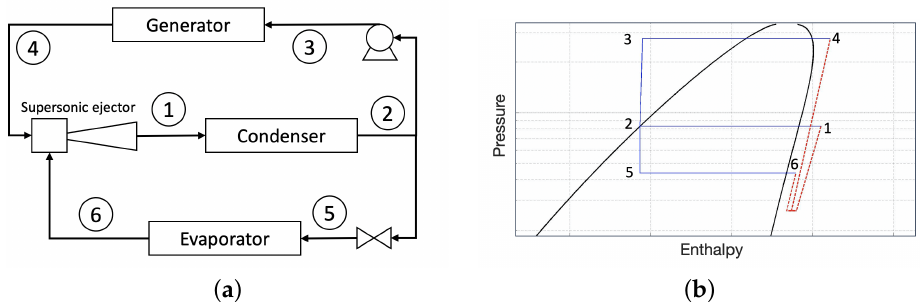
Figure 1. ( a ) General schematics of the HDRC, along with ( b ) its corresponding pressure–enthalpy diagram.